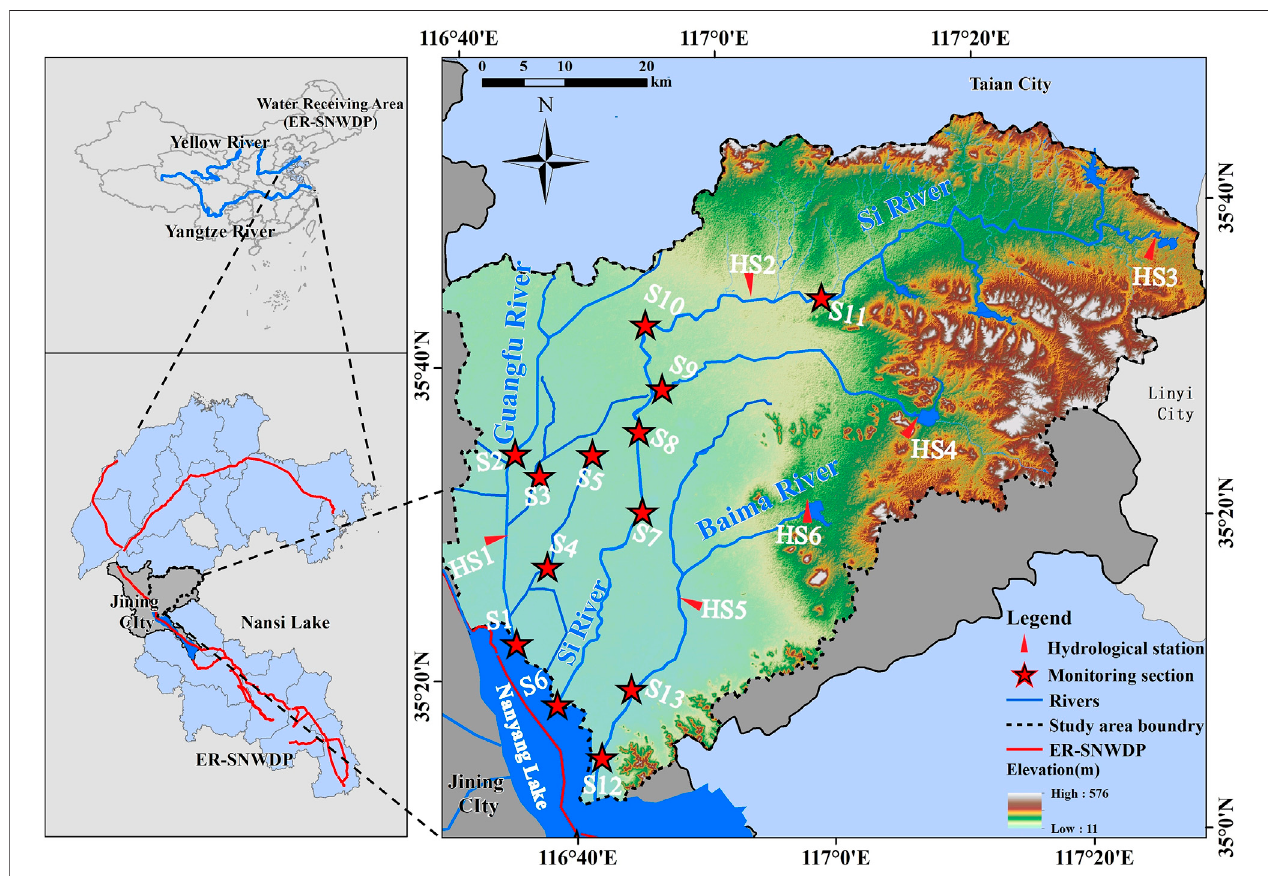
FIGURE 1 | Overview of the study